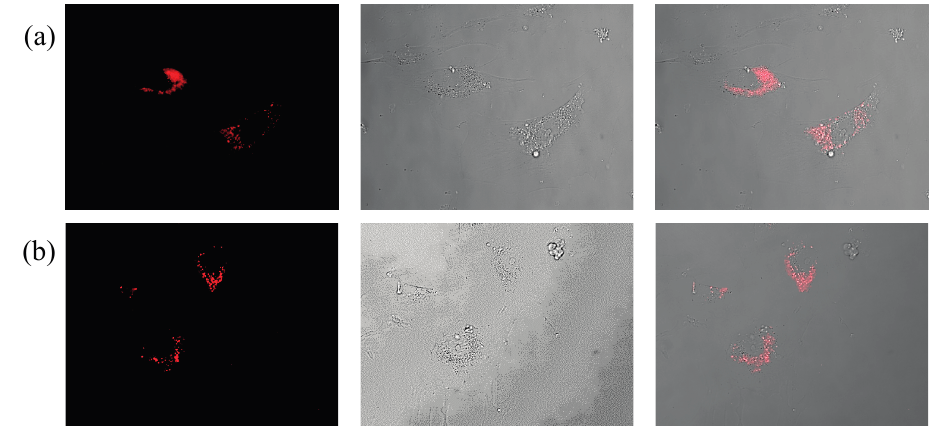
Figure 12. Internalization of functionalized Au NPs by human umbilical vein endothelial cells. HUVECs were exposed to TAMRA-labeled Au NPs functionalized with ( a ) anti-VEGF (Au-PEG-antiVEGF NPs), and ( b ) anti-HRP antibodies (Au-PEG-anti-HRP NPs). The NP-antibody conjugates were removed after 2 h and the cells were intensively washed. The images were taken 1 h later by employing a Zeiss fluorescent microscope. Images show the fluorescence and bright field channel, as the overlay of both channels.